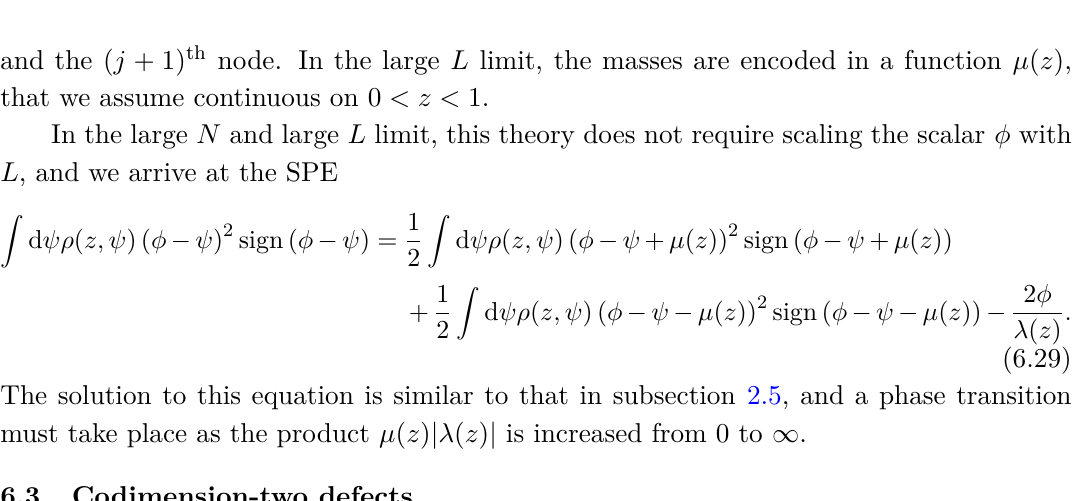
Figure 20 . A 3 d Chern-Simons theory on the defect, drawn with shaded nodes. The last node is the five-dimensional gauge group, seen as a flavour symmetry from the 3 d